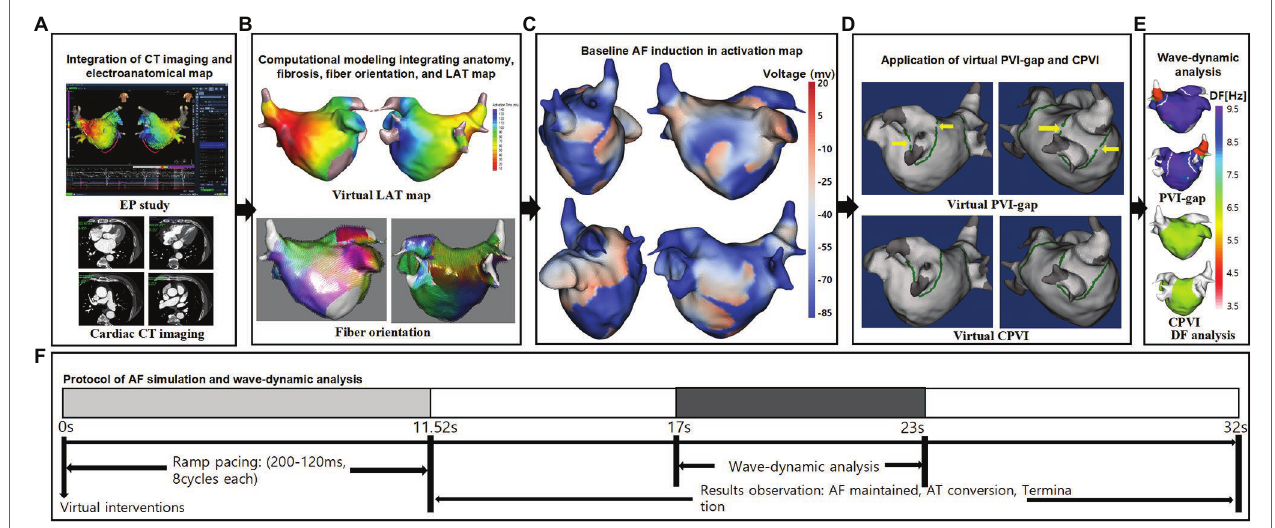
FIGURE 1 | Study protocol of the computational atrial modeling and AF simulation. (A) CT merged 3D-clinical electroanatomical map. (B) Clinical map integrated computational modeling. (C) Baseline AF induction in activation map. (D) Application of CPVI and PVI-gap. The yellow arrows indicate gaps in the PVI. (E) DF-based wave-dynamics analyses. (F) Study protocol. CT indicates computed tomography; EP, electrophysiology; LAT, local activation time; PVI-gap, pulmonary vein isolation with gap; CPVI, complete pulmonary vein isolation; DF, dominant frequency; AF, atrial fibrillation; AT, atrial